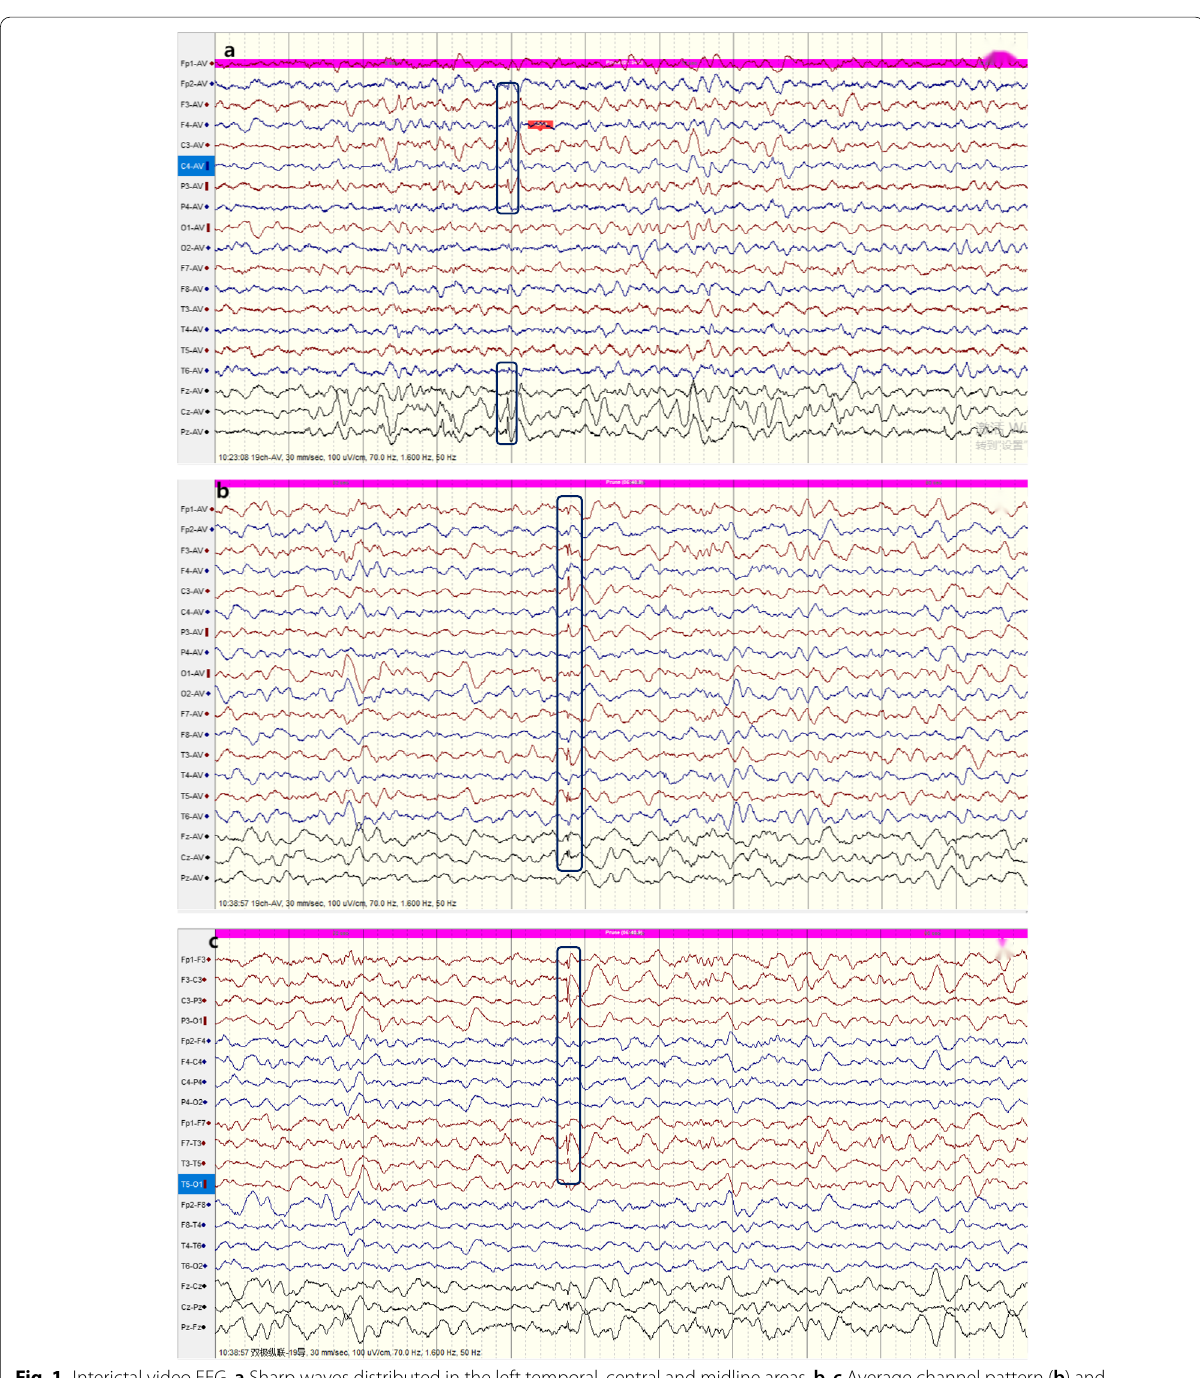
Fig. 1 Interictal video EEG. a Sharp waves distributed in the left temporal, central and midline areas. b , c Average channel pattern ( b ) and longitudinal bipolar channel pattern ( c ) from the same interictal EEG. At the longitudinal bipolar channel pattern, phase inversion of C3 was seen. Rectangular boxes show sharp